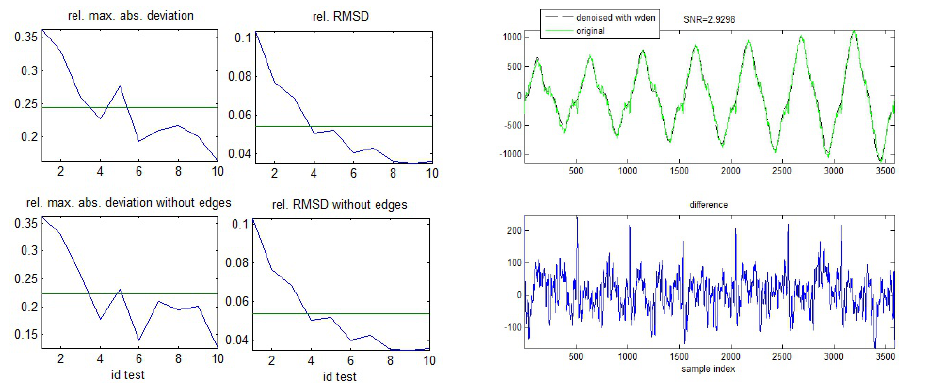
Figure 12. Metrics for WPT-based denoising of signals with ascending slope, M = 0.06. Left fig- ures –MAD. Right figures – RMSD. Top – for all elements. Bottom, without 3 elements nearby each edge.